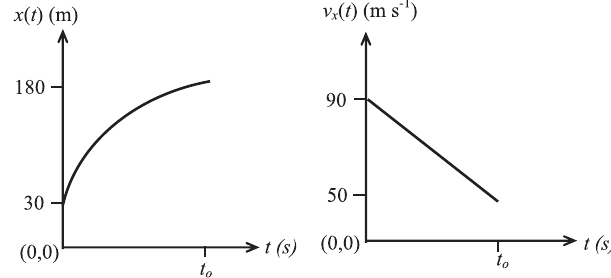
FIG. 2. Kinematic task with graphical format requesting quan- titative